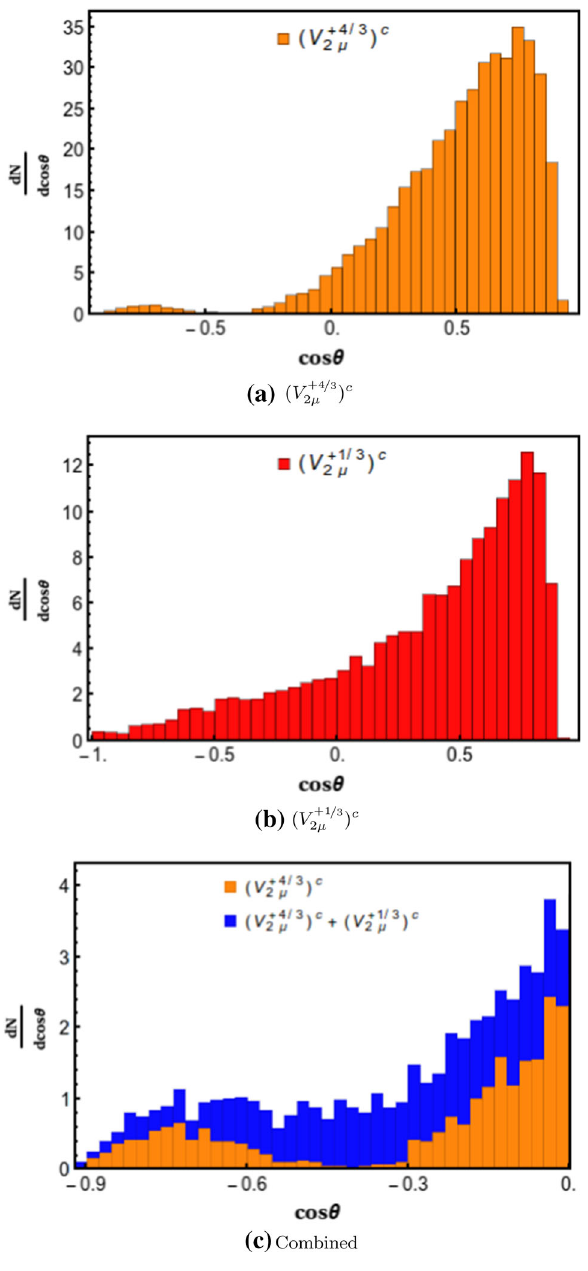
Fig. 12 Angular distribution of photon with respect to the electron √ s = 318 . 12 GeV and L int = 100 fb − 1 for the associated beam, at production of 70 GeV vector doublet leptoquark V c